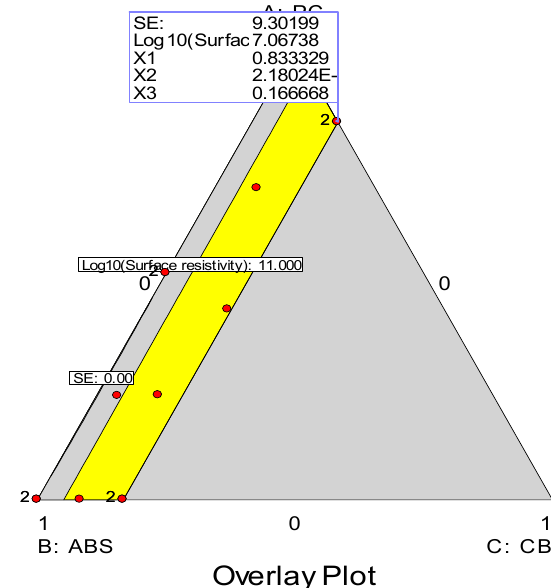
Figure 11. Overlay mapping @ 800 MHz with carbon black masterbatch.